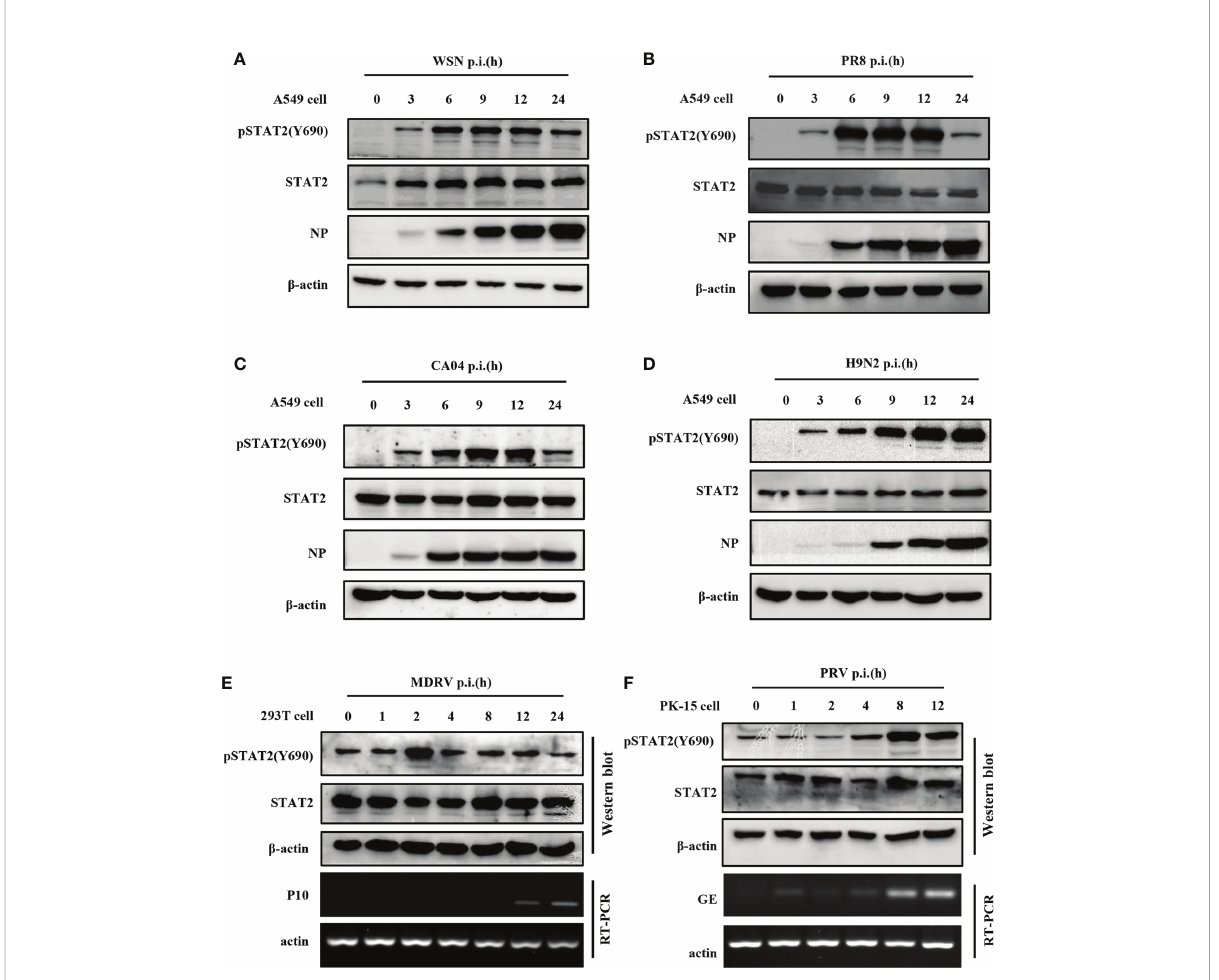
FIGURE 1 Phosphorylation of STAT2 can be induced by several viruses at early infection stage. (A – D) A549 cells were infected with IAV strains, including WSN (A) , PR8 (B) , CA04 (C) , and H9N2 (D) at indicated time points. Cell lysates were collected to detect the corresponding protein by Western blotting. NP, IAV nucleoprotein. Diagram shows representative data from three independent experiments. (E, F) 293T cells were infected with MDRV (E) and PK15 cells infected with PRV (F) at corresponding time points. Corresponding proteins were detected by Western blotting, the corresponding mRNAs were detected by RT-PCR. P10, the non-structural protein of MDRV. GE, glycoprotein E of